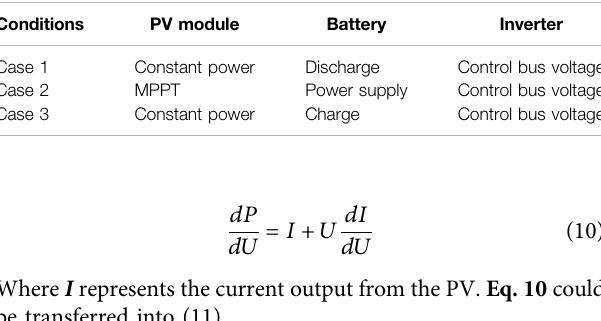
TABLE 2 | Control objects and